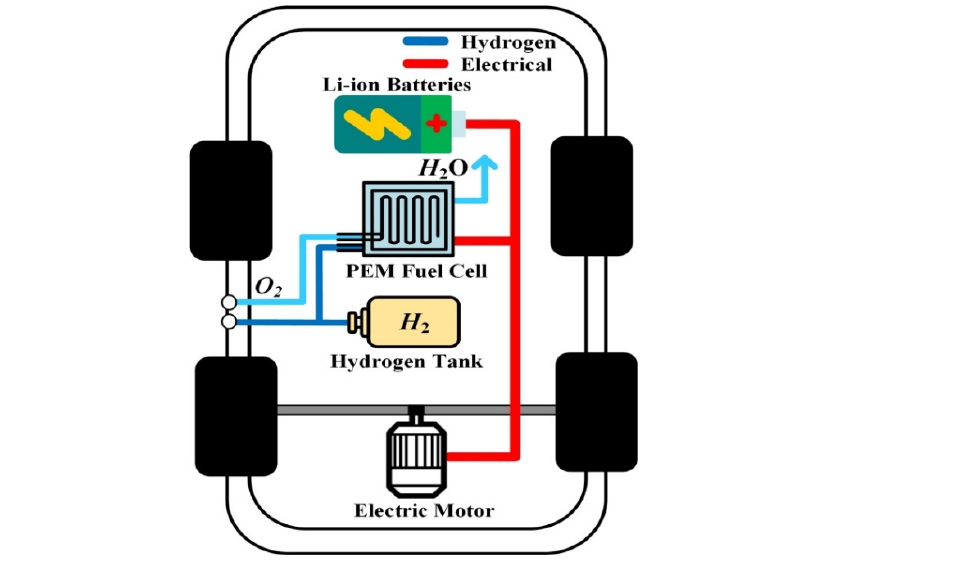
Figure 7. Example of FCEV powertrain. Table 1. Summary of the commercial FCEV available for sale or leasing [57–59].